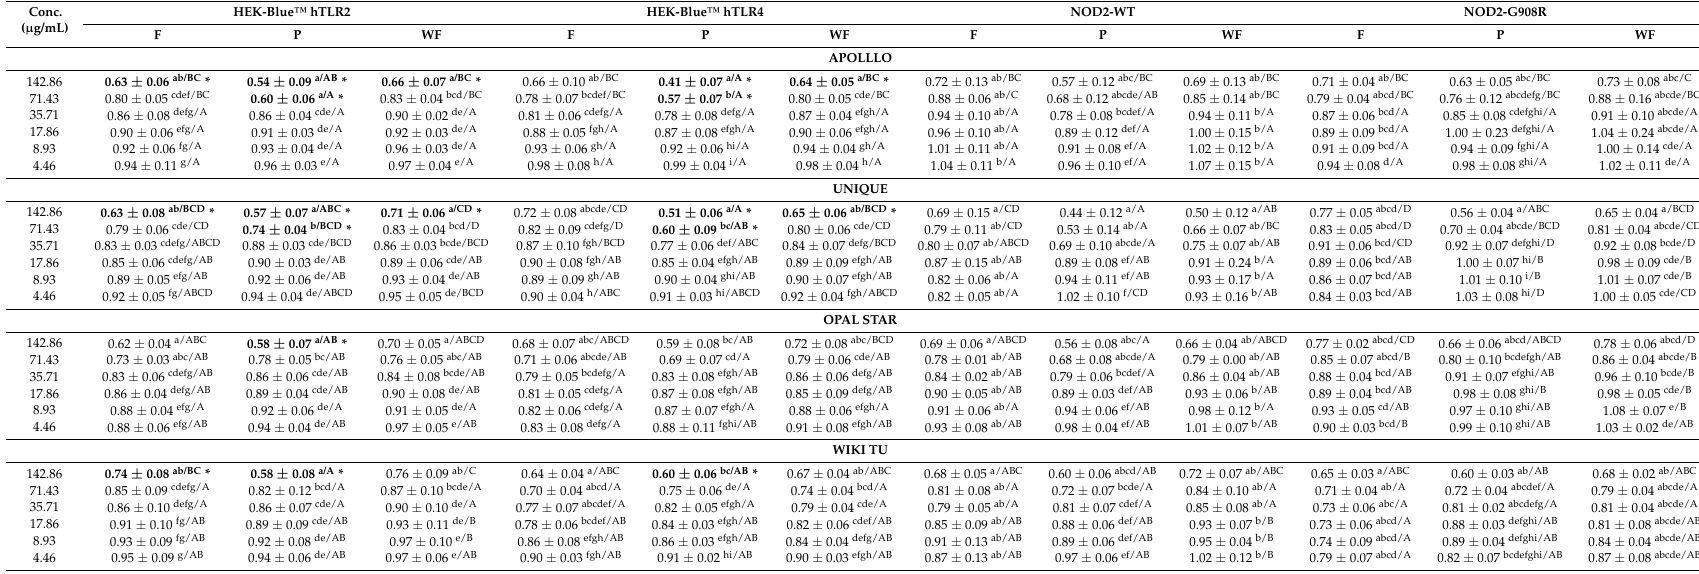
Table 2. Cell viability of the HEK-Blue and NOD2 cell lines treated with feijoa extracts (WST-1